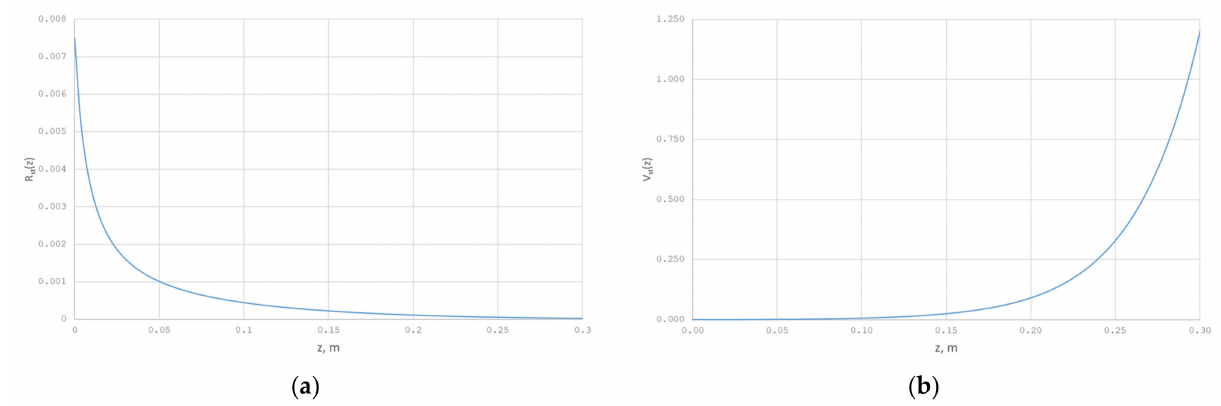
Figure 21. ( a ) Radius of the silica melt flow, ( b ) Velocity of the silica melt flow.